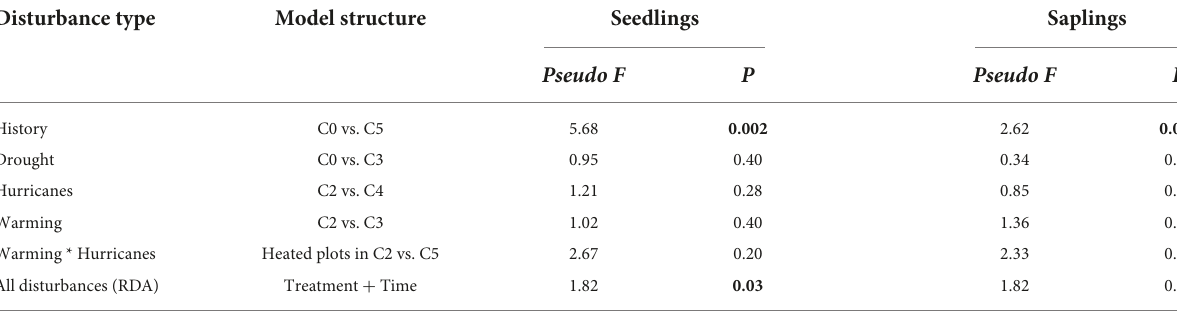
TABLE 1 Results of permutational multivariate analysis of variance (PERMANOVA) between each disturbance type and its respective control conditions for seedling and sapling species composition. Disturbance type